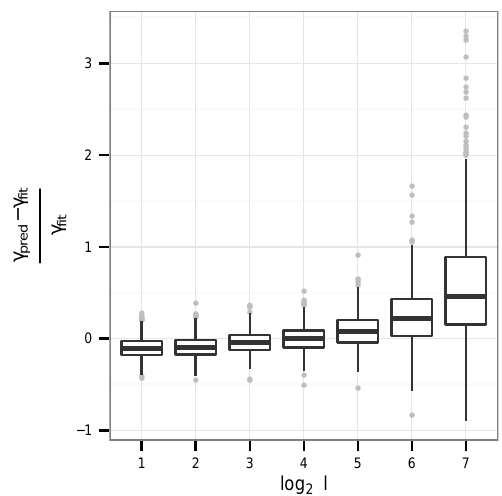
Figure 20. The difference between the relative error of the distribu- tion without correlation, and that with correlation propagated from the largest scale. The inclusion of correlations leads to small, but consistent, improvements (i.e. negative values). It is immediately clear that the coarsest scale is not well captured by the functions, evidenced by the large relative error. Figure 19. The parameters for the correlation of the increment, shown as boxplots for each storm. The functions for the correlation appear stable throughout winter and summer and have a high inter- cept, but a low slope suggesting that the correlation is somewhat the same for all scales.